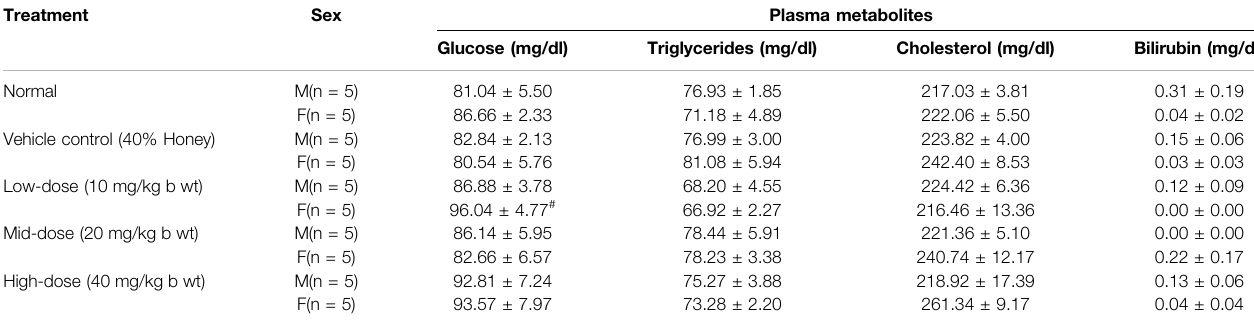
TABLE 5 | Effect of in-house Thamira parpam on 28th day: biochemical parameters (Metabolites). Treatment Sex